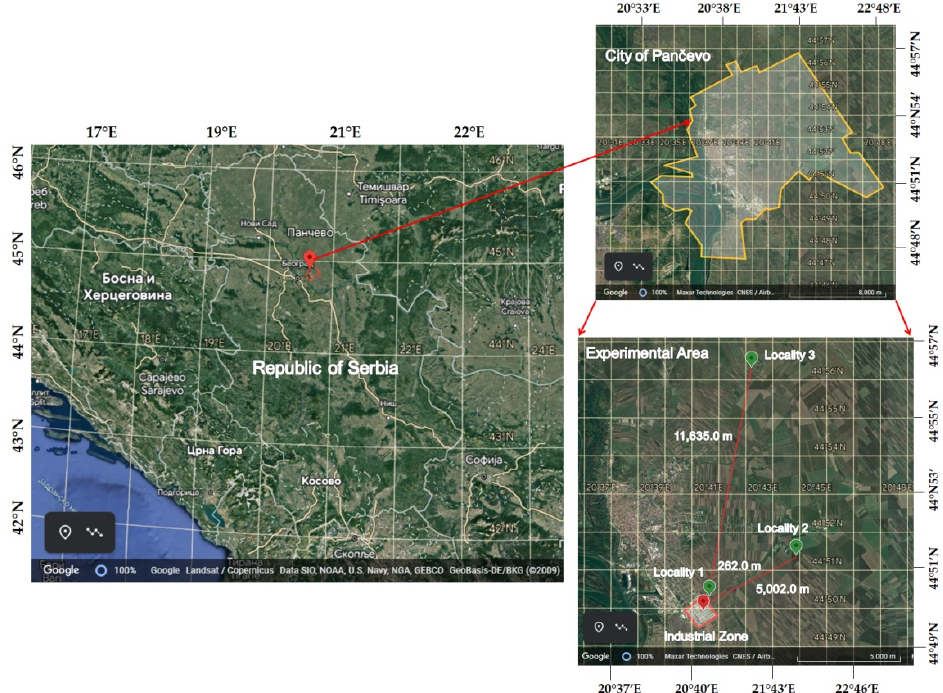
Figure 1. Map of the studied localities (https://earth.google.com/web/ (accessed on15 November 2022) [63].